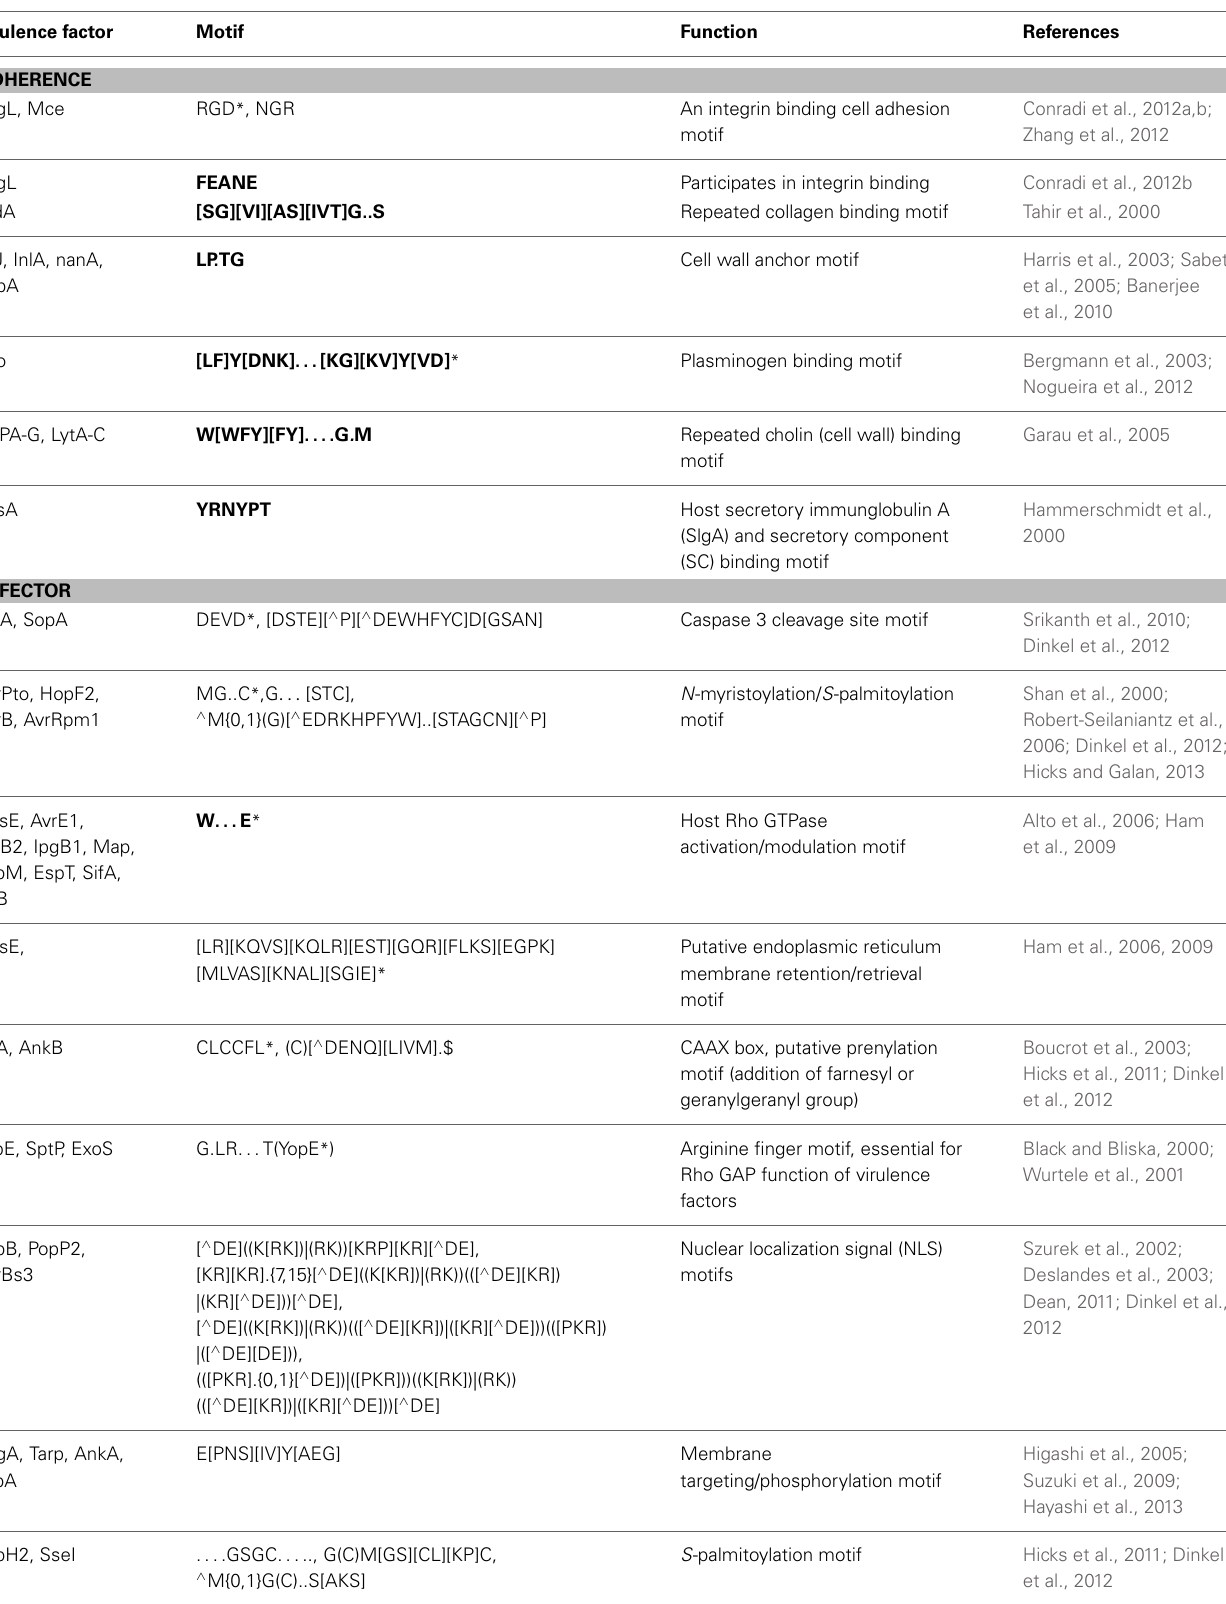
Table 1 | Examples of known instances of Short Linear Motifs in bacterial virulence